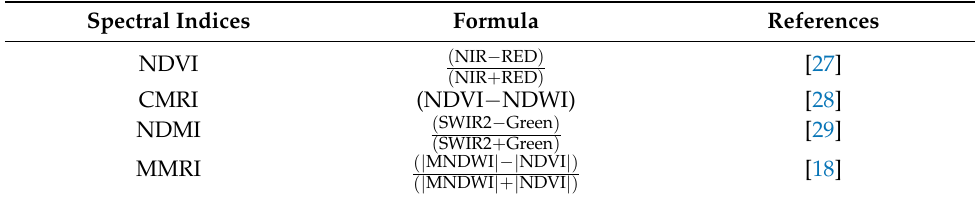
Table 2. Spectral indices